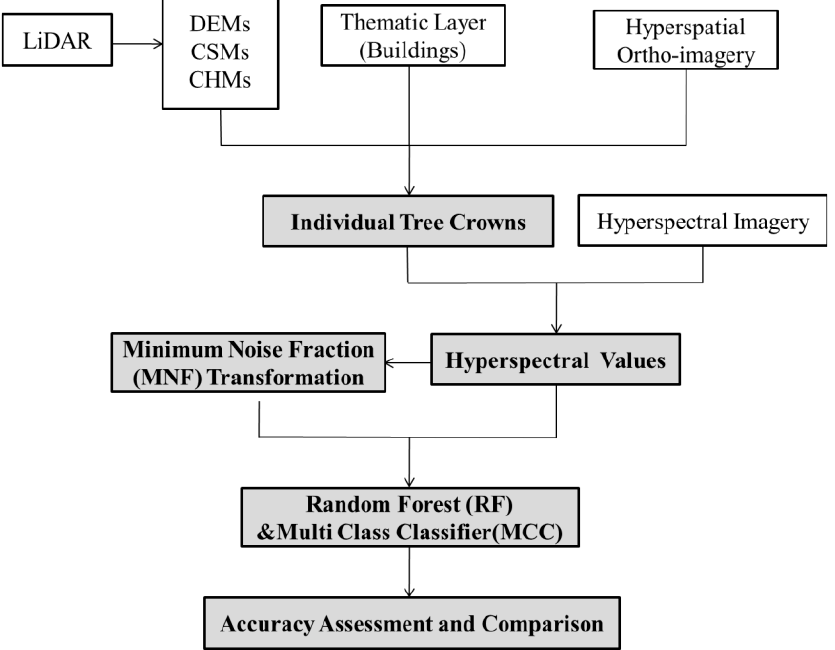
Figure 1. Flowchart for integrating LiDAR data with hyperspectral imagery for tree species identification at the individual tree